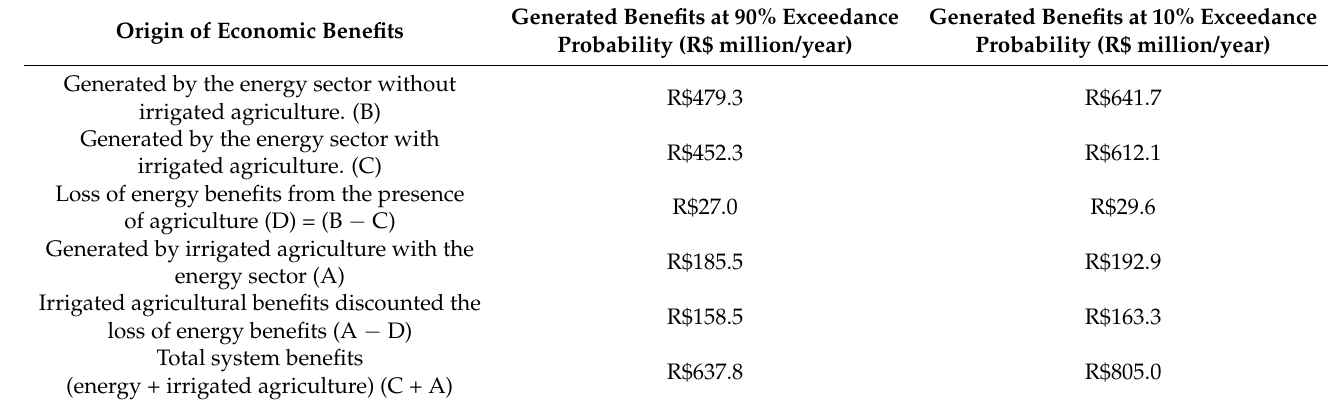
Table 7. Economic